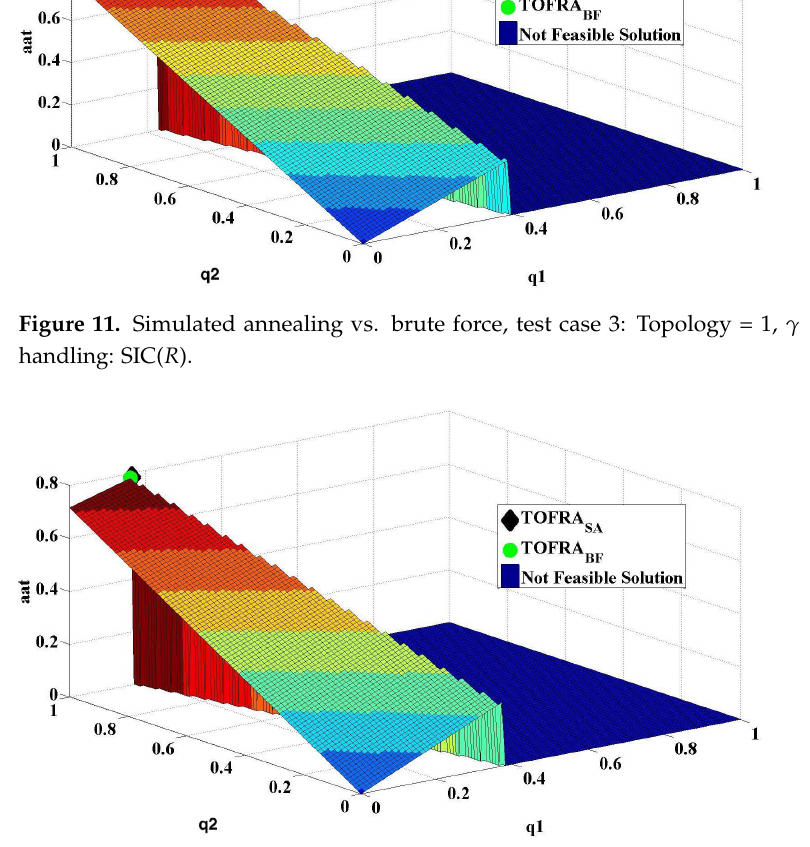
Figure 12. Simulated annealing vs. brute force, test case 4: Topology = 1, γ = 2.0, Interference handling: SIC( R ).